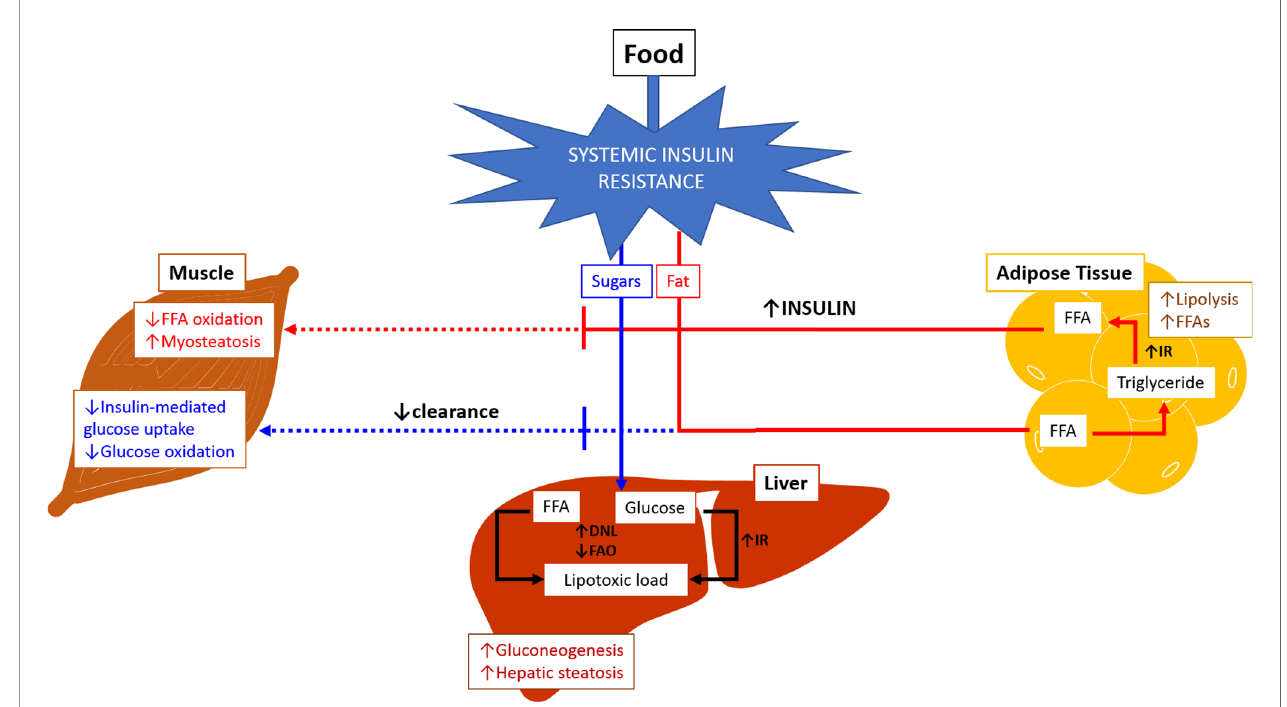
Type of Results metabolites sample Short Chain Blood ↑ abundance of enzymes associated with lactate, acetate, and Fatty Acids formate in mild/moderate NAFLD. ↑ abundance of enzymes for butyrate, D-lactate, propionate, and succinate in advanced fi brosis. ↑ serum 3-phenylpropanoate in advanced fi